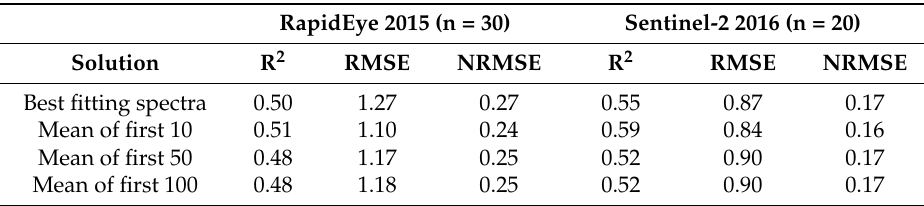
Table 3. R 2 , RMSE and normalised RMSE (NRMSE) (m 2 /m 2 ) values between measured and estimated LAI in Schiermonnikoog using RapidEye data in 2015 (n = 30) and Sentinel-2 data in 2016 (n = 20) and LUT inversion (utilising the minimum RMSE criterion, mean of the best 10, best 50 and mean of the best 100 solution.